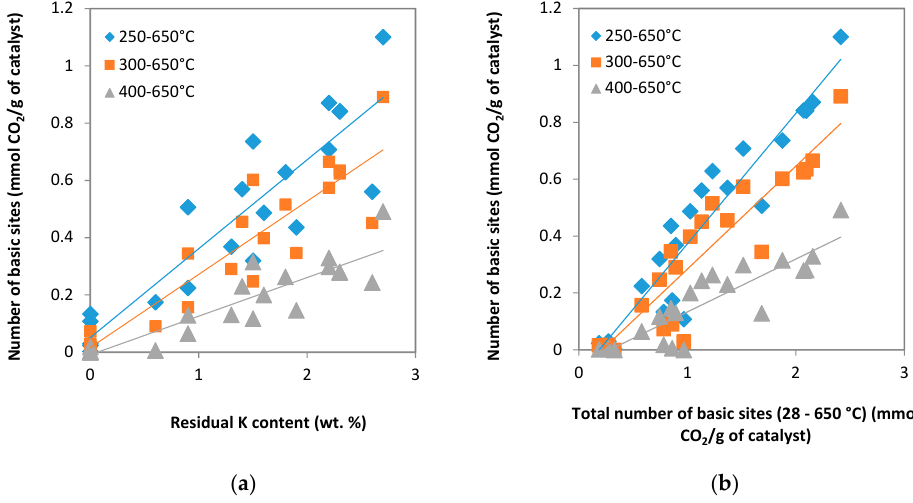
Figure 8. TPD-CO 2 results: ( a ) dependence of the number of basic sites on the potassium content, and ( b ) dependence of the number of basic sites (250–650 °C, defined by the temperature region of CO 2 desorption) on the total number of basic sites (28–650 °C).